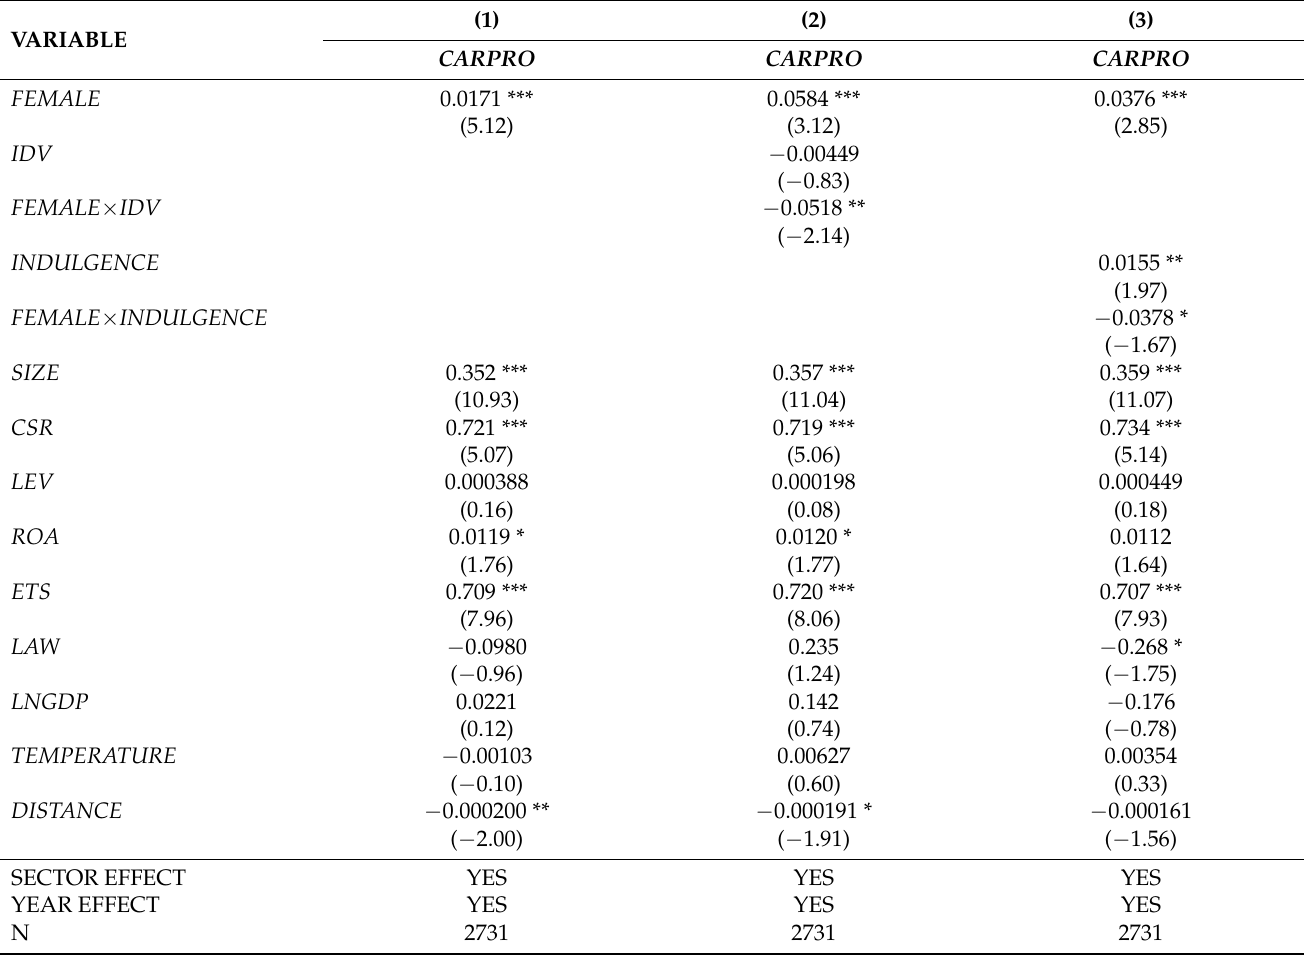
Table 6. Results of OML Regression Based on Board Gender